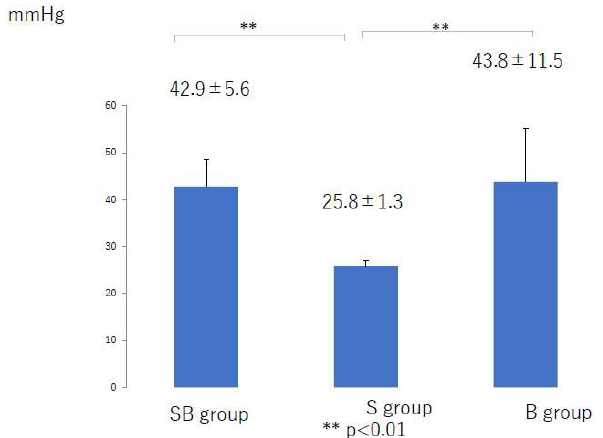
Figure 2. Mean compression pressure applied to the lower limb during the first 6 months after liposuction. B, bandage only; SB, compression stocking and bandage; S, stocking only.